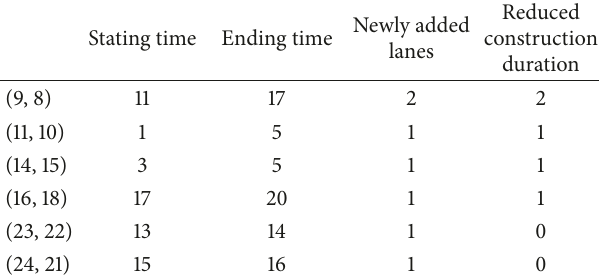
Reduced Newly added lanes